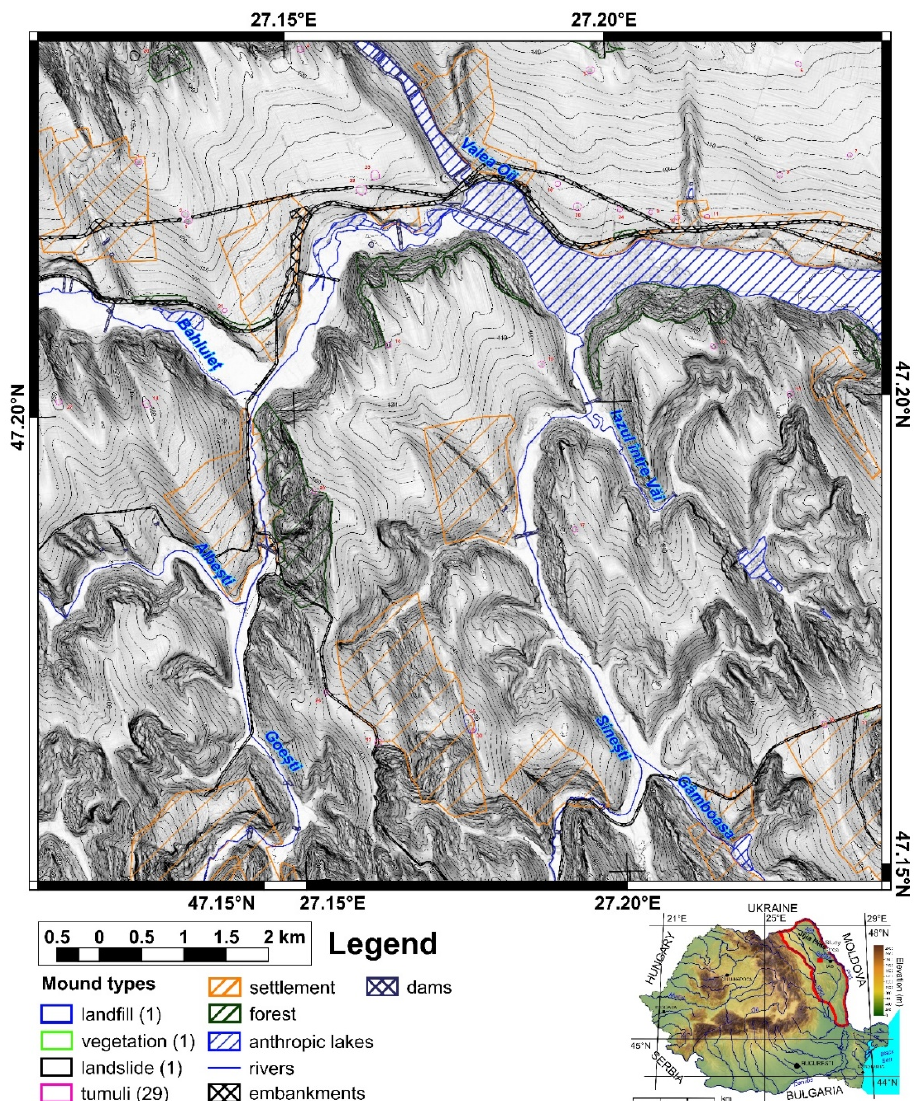
Figure 2. The geographic position of the southern study area and the location of the delineated mounds. (a high-resolution version can be found at https://doi.org/10.6084/m9.figshare.11798613.v2)